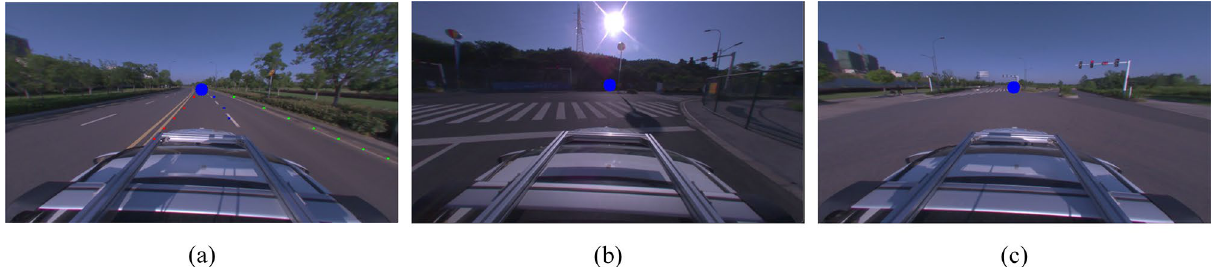
Figure 8. Vanishing point detection in curved